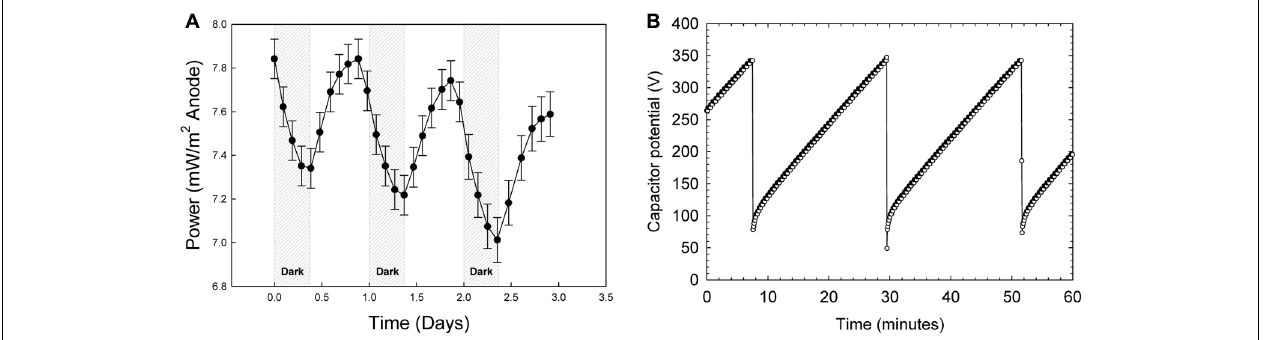
FIGURE 5 | (A) Power generation by the mat fuel cell showing oscillations in tandem with the diel cycle where maximum power occurred near the end of each light cycle and reached a minimum at the end of the dark cycle. (B) An example charge/discharge cycle.The shorter charging time corresponds to higher power